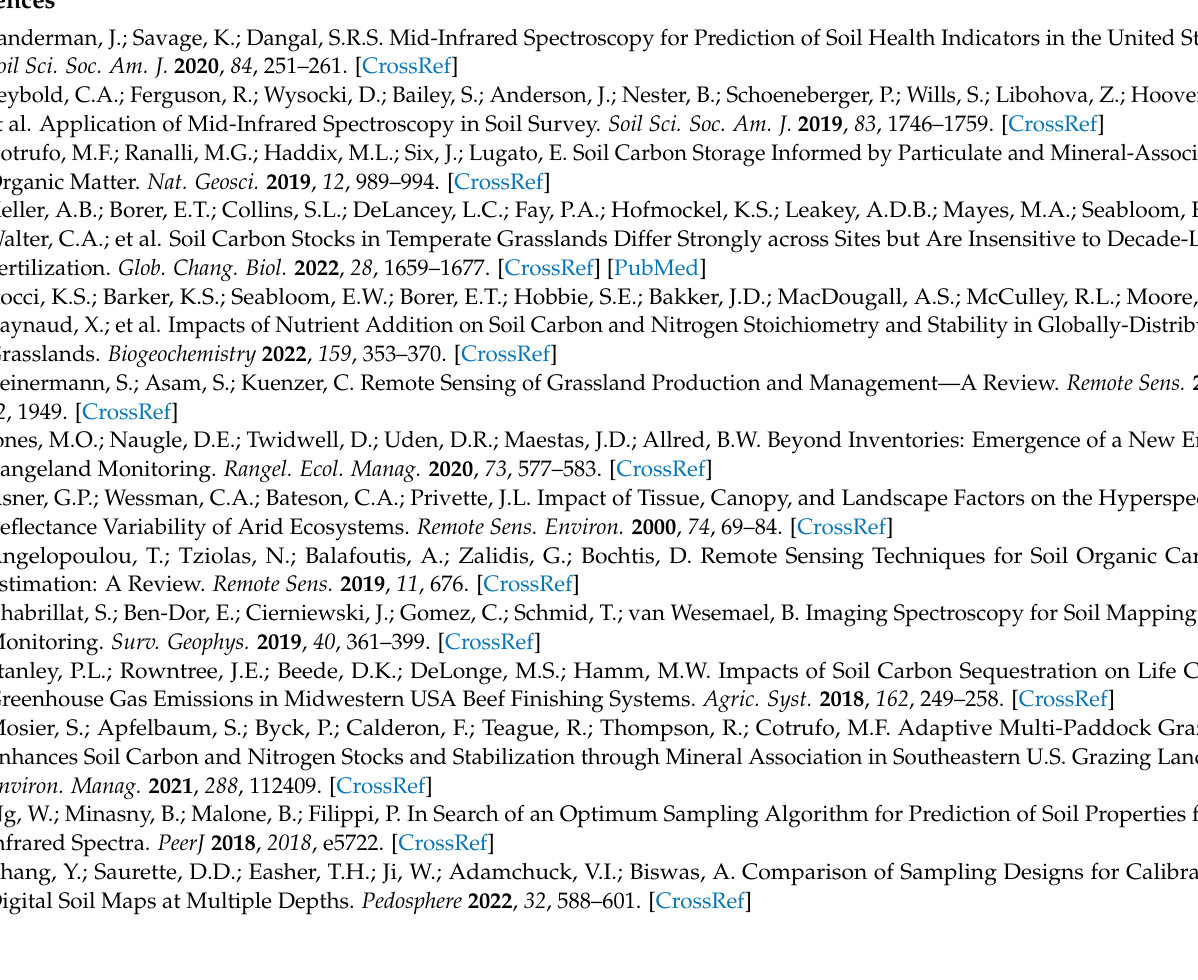
(PCA) score plot showing farm pairs (1 to 5) with high spatial spectral heterogeneity between soils. Axis 1 accounts 42% of variance in the data set and Axis 2 accounts for 25%; Figure S2: Frequency histograms for calibration (1000 samples) and validation dataset (612 samples) dataset for A) soil organic carbon (SOC) and (B) total soil nitrogen (N). The predictions were achieved by keeping the same frequency distribution between the calibration and validation dataset using a Kennard-stone sampling algorithm; Figure S3: Effect of sampling grazing practice and farm-pair soil on soil organic carbon (SOC) prediction using partial least squared (PLS). The training dataset contains 400 samples. All standardized residuals (residual = measured – predicted) were then plotted against their predicted C content. If the calibration model is appropriate, the residuals should be distributed randomly around the y = 0